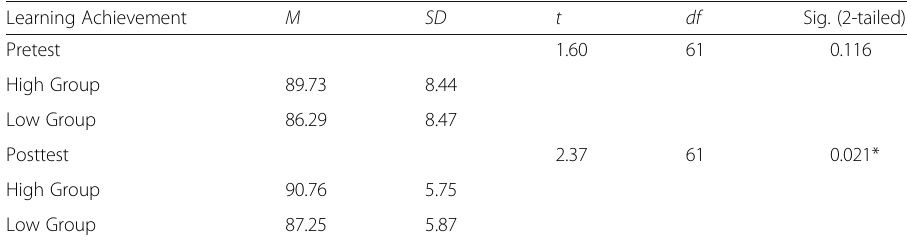
Table 4 Comparison of Learning achievement between high and low group Learning Achievement